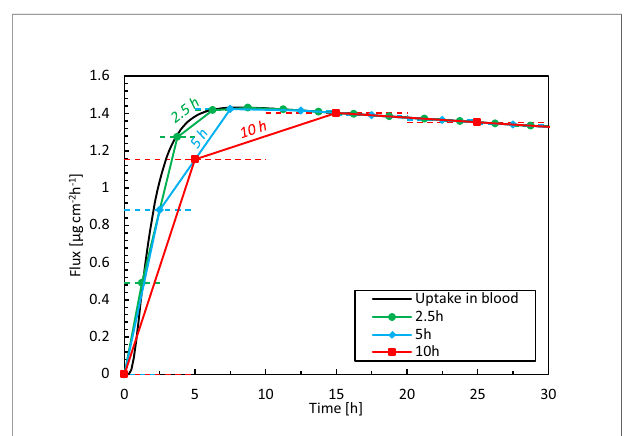
FIGURE 7 | Flux taken up by the blood as a function of time for 3 time- averaging intervals, based on simulation data. The horizontal dashed lines indicate the time range over which the averaging took place, i.e., 2.5, 5, or 10